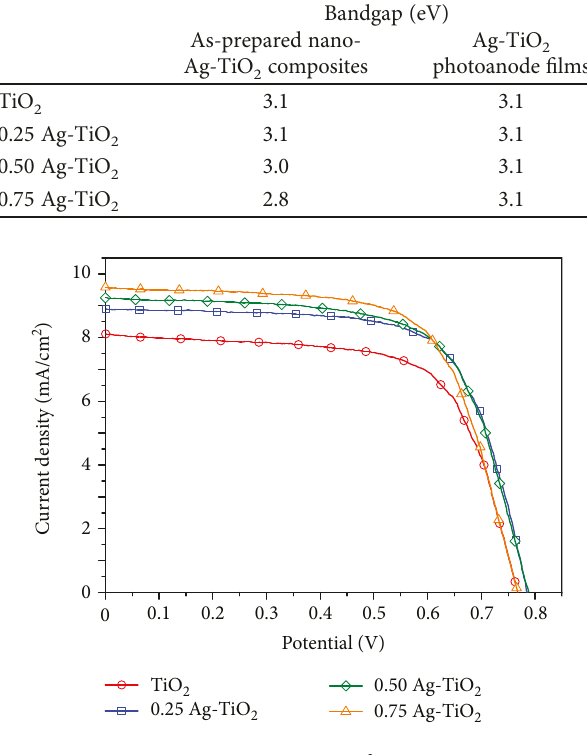
Table 2: Bandgap energy ( E composites in powder and Ag-TiO by the Kubelka-Munk plot.